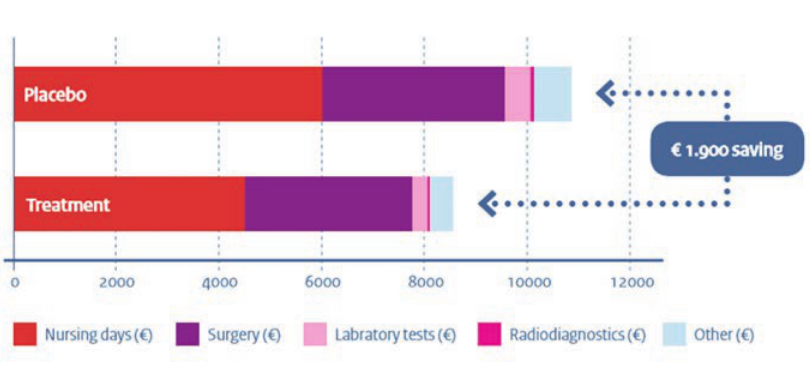
Figure 3. Mean hospital costs per patient for placebo and treatment